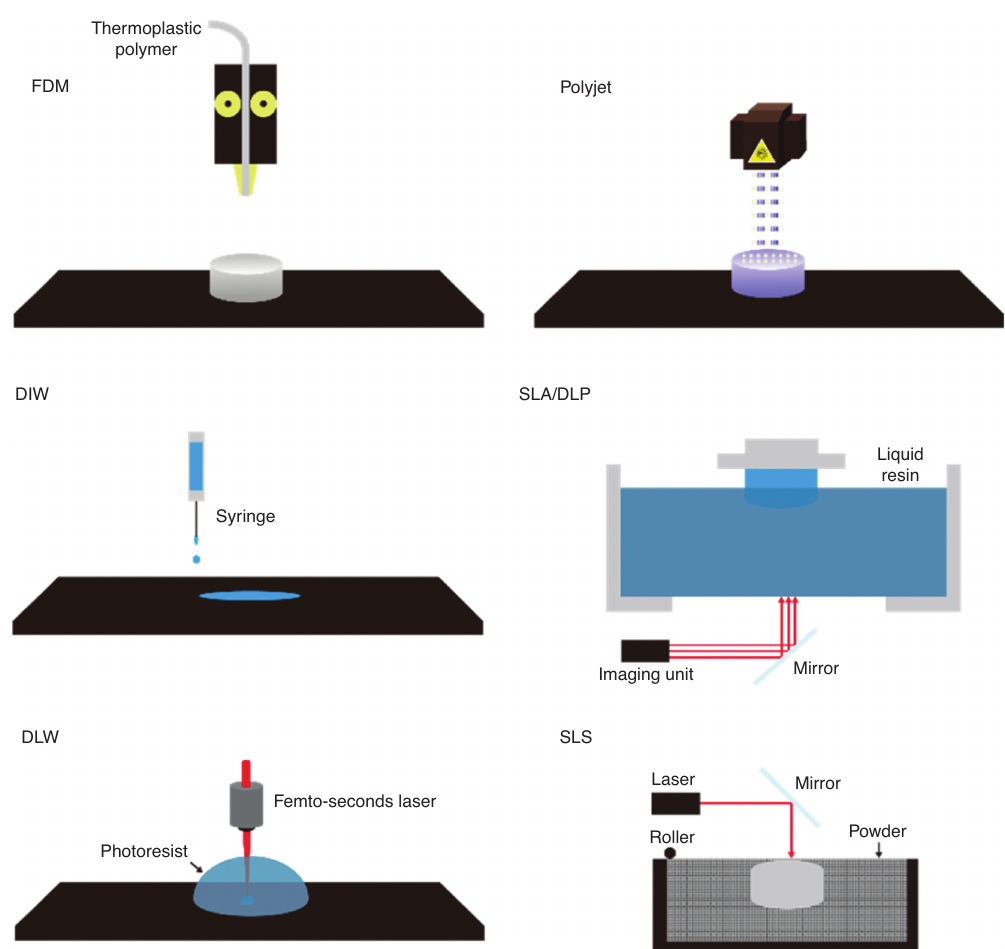
Figure 1: Schematics of the 3D printing methods: Fused deposition modeling (FDM), PolyJet (or Material jetting), Direct ink writing (DIW), Stereolithography (SLA)/Digital light projector (DLP), Direct laser writing (DLW), Selective Laser Sintering (SLS).